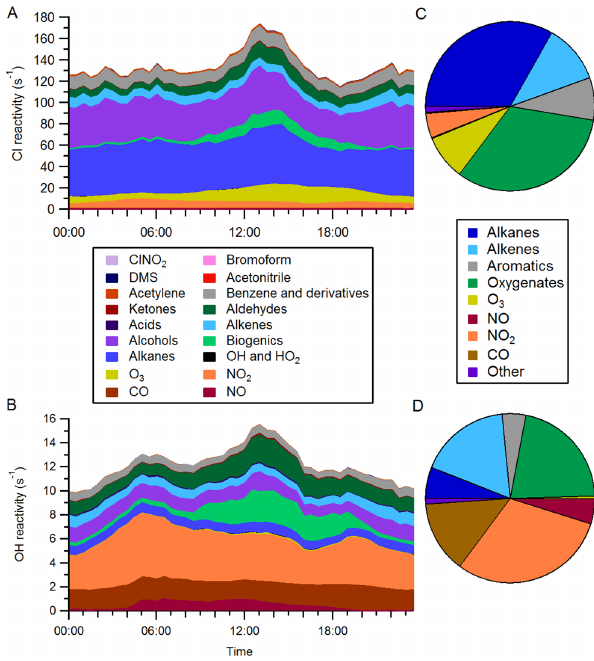
Fig. 7. Reactivity averaged over a diurnal cycle for (A) Cl and (B) OH; Pie charts showing relative contributions to reactivity during daylight hours for (C) Cl and (D) OH calculated from measure- ments made in Pasadena during the CalNex